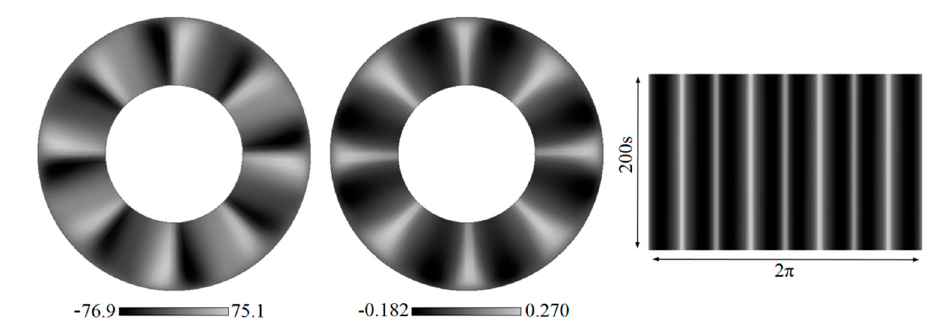
Figure 8. Snapshots of the surface azimuthal velocity (left), concentration fluctuations (middle) and the corresponding spatiotemporal diagram (STD) at R = 0.75 when Re T = 6.0 × 10 3 .